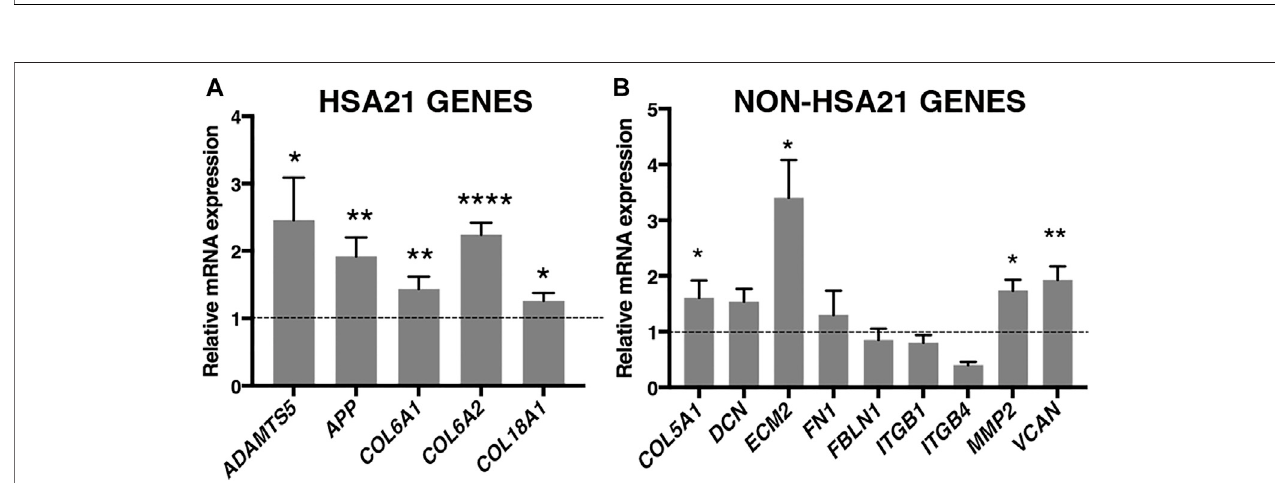
FIGURE 2 | ECM genes are signi fi cantly upregulated in trisomic fi broblasts. Relative mRNA expression of Hsa21 (A) and non-Hsa21 (B) genes coding for ECM proteins, measured by qRT-PCR and normalized to a reference gene ( GAPDH ). Values represent the average determination from at least 2 qRT-PCR experiments. Resultsare expressed as relative mean values ±SEM of cell cultures from four trisomic samples, compared with apool ofeuploid controls (set equal to1 =dashed line). * p -value ≤ 0.05, ** p -value ≤ 0.01, **** p -value ≤ 0.0001.